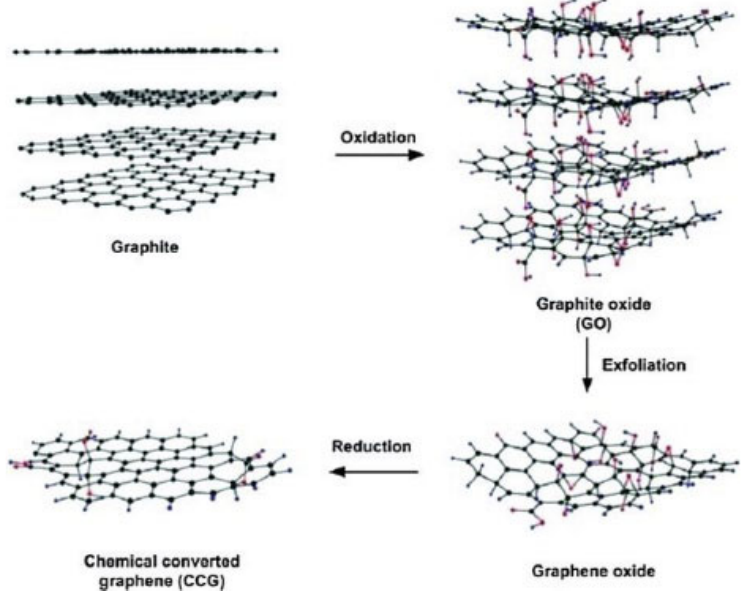
Figure 1. Preparation of graphene by chemical reduction of graphene oxide synthesized by Hummers’ method. Reproduced with the permission from [84].